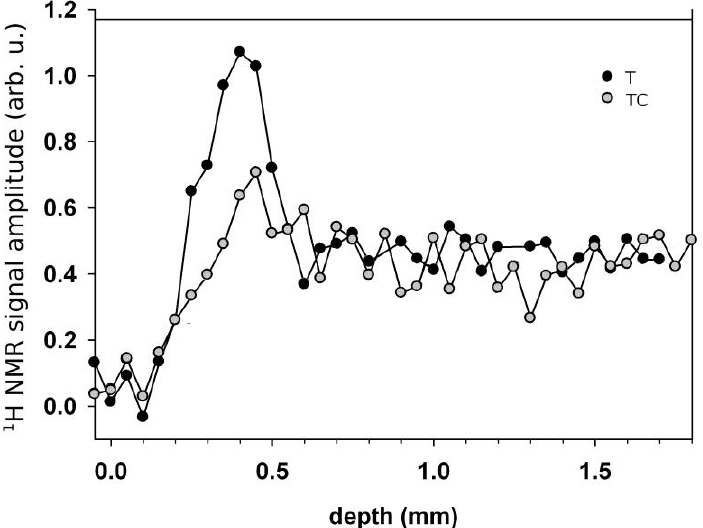
Figure 2. 1 H NMR depth profiles in the presence of a degraded organic layer of shellac (T), and after applying a cleaning procedure to remove shellac (TC). Adapted from [55]. Copyright Nova Science